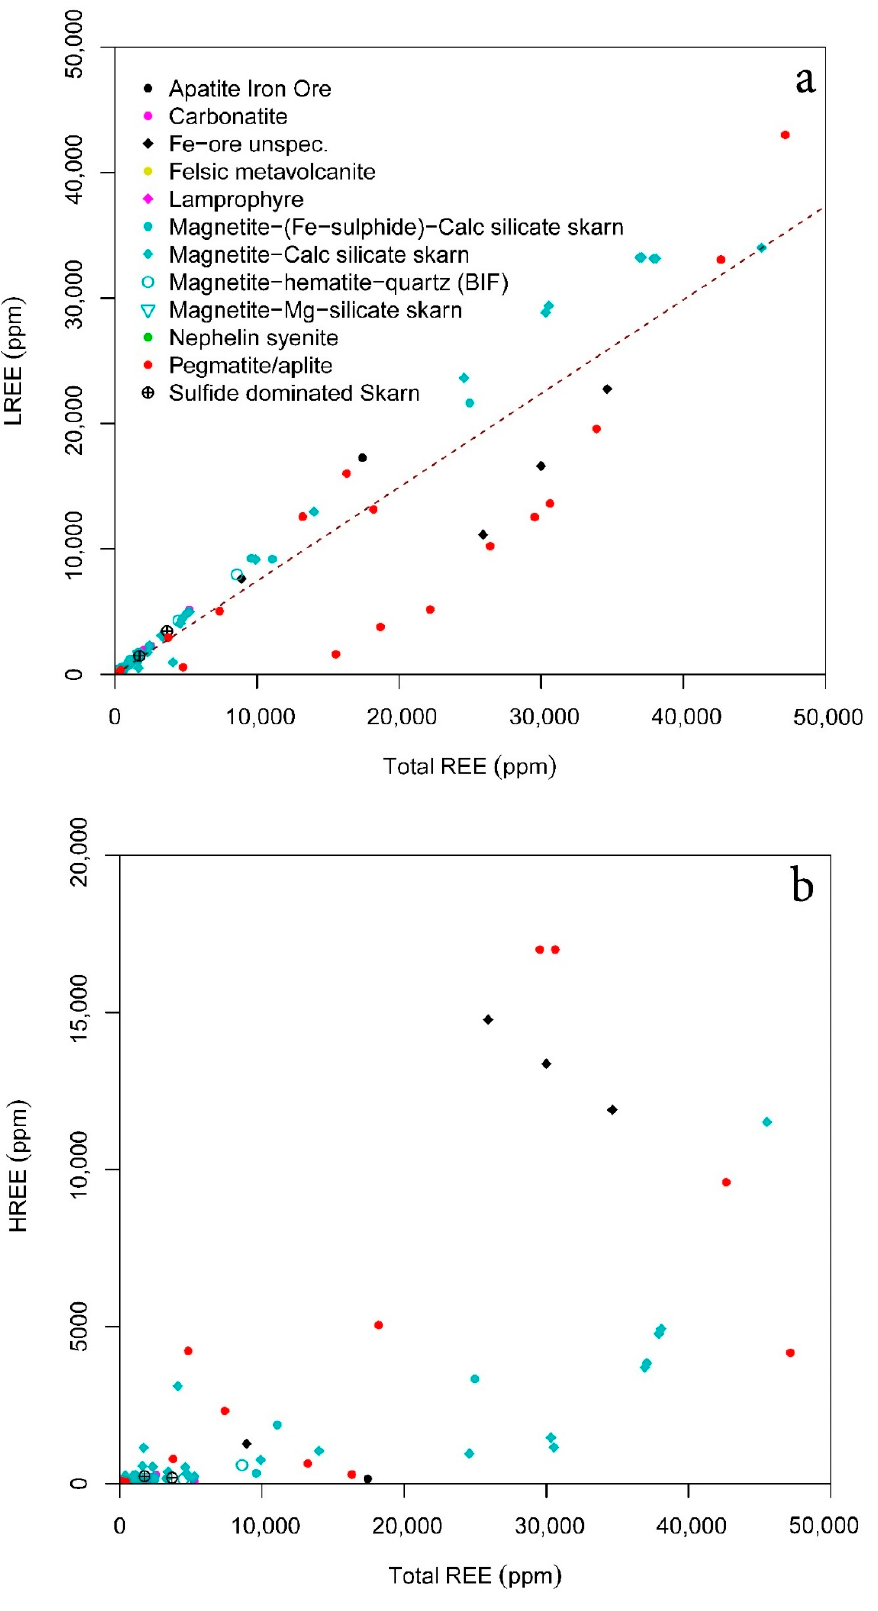
Figure 5. Bivariate diagrams of total REEs versus LREEs ( a ) and HREEs ( b ) for EURARE project samples.